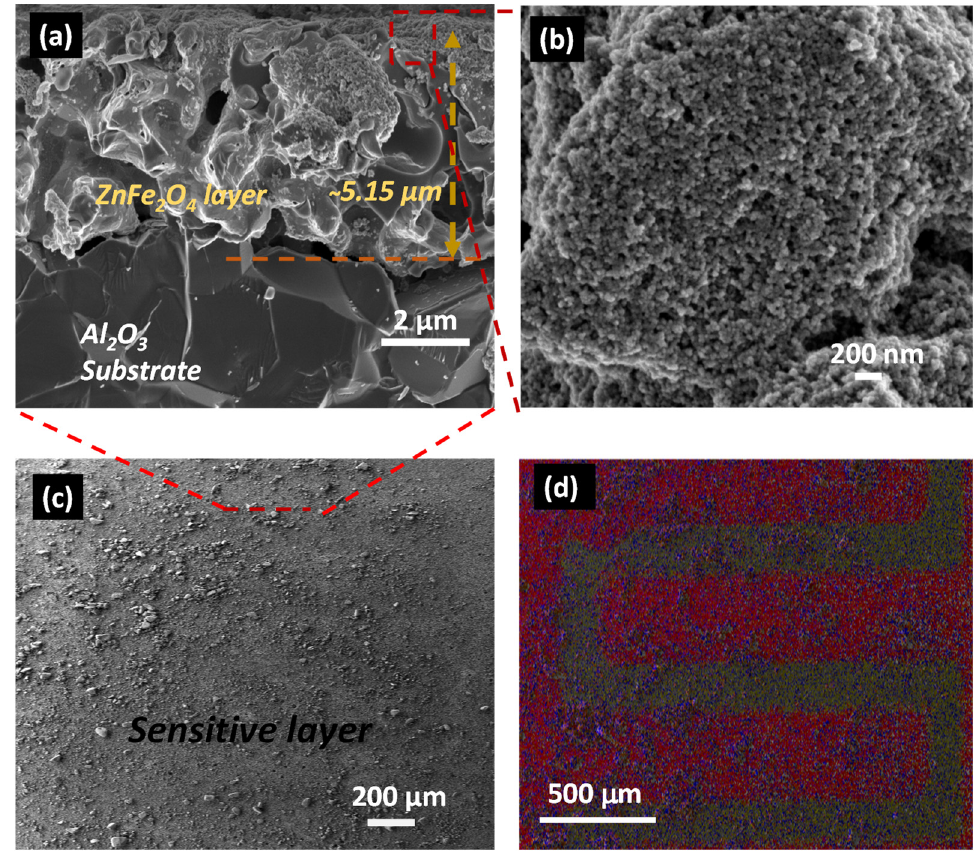
Figure 4. ( a ) Cross-sectional image of the ZnFe 2 O 4 NP sensing film prepared at 2 µL. ( b ) High magnification top view of the sensing film and ( c ) top view displaying distribution of ZnFe 2 O 4 NPs across Al 2 O 3 interdigitated electrodes. ( d ) SEM elemental maps of the ZnFe 2 O 4 NP sensing film.